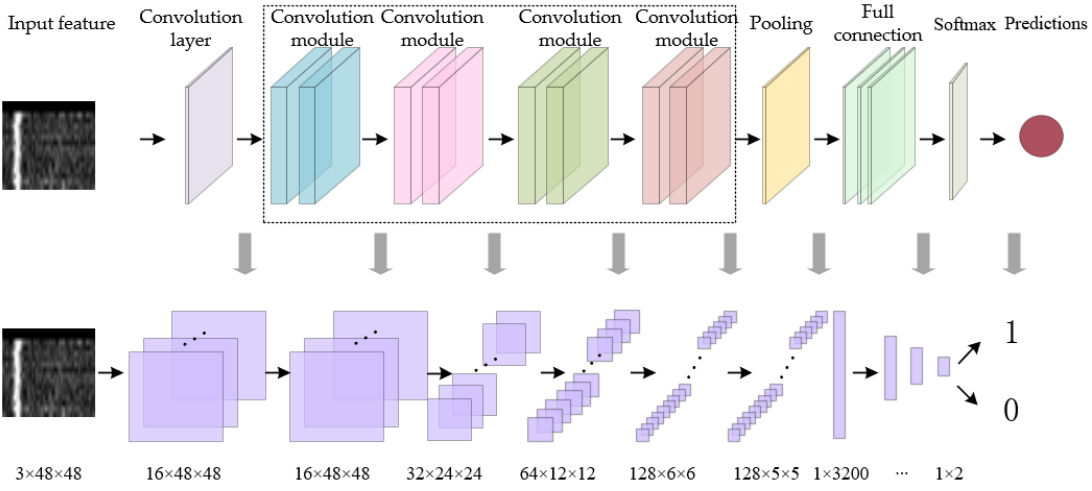
Figure 1. AR_Net